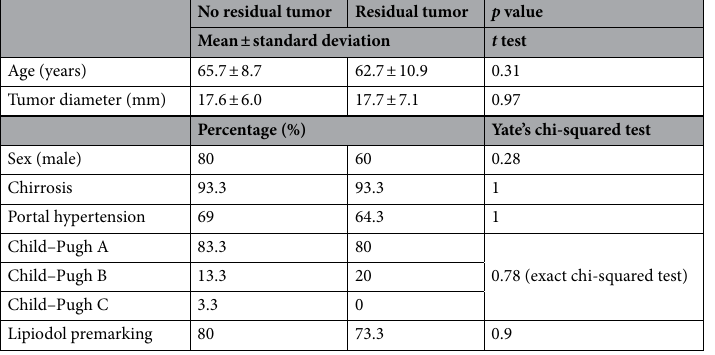
Table 1. Baseline characteristics.